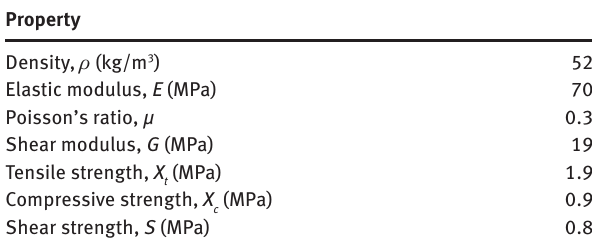
Table 2: Properties of ROHACELL 51IG